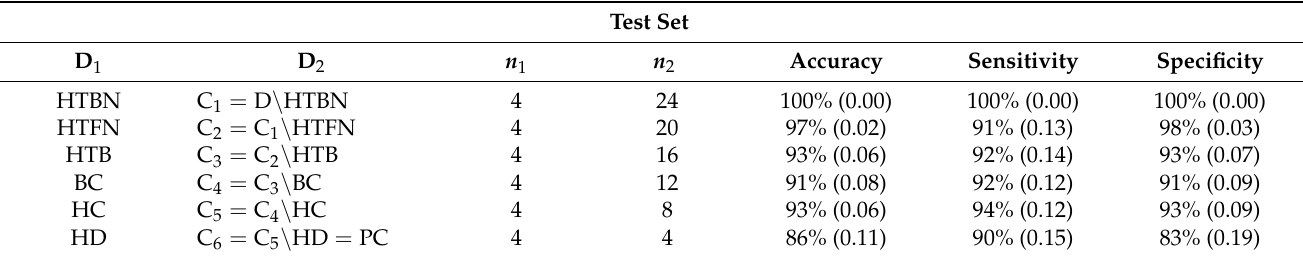
Table 2. Classification accuracies, sensitivities, specificities and the corresponding standard deviations of the testing sets at the six nodes in Figure 4.